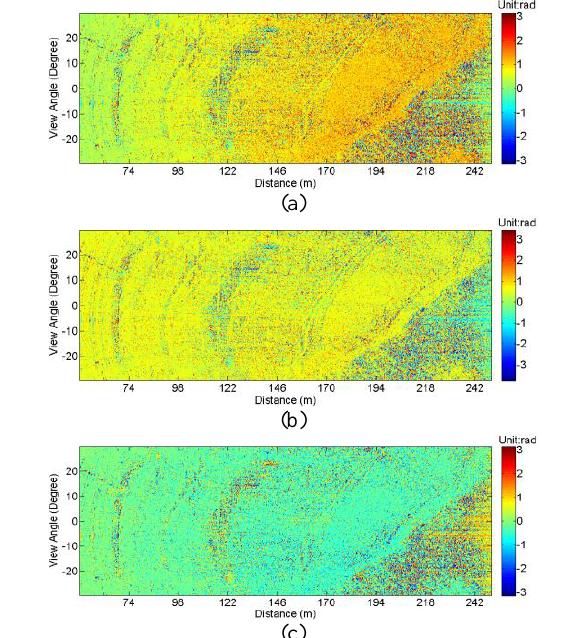
Figure 6. Comparison of empirical models. (a) Original interferogram. (b) Quadratic model compensation result. (c) Empirical model compensation result.